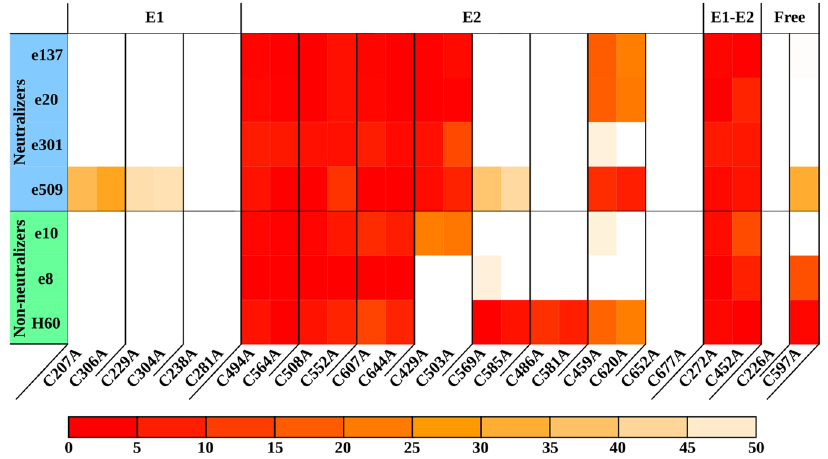
Figure 1. C-to-A reactivity pattern. Antibodies are divided into neutralizers and non-neutralizers. Each cysteine mutant was tested against the mAb panel. Disulfide bridges and free cysteines selected on the basis of their reactivity are reported. Reactivities below 50% compared to WT are depicted as a heatmap spanning from light orange (50%) to red